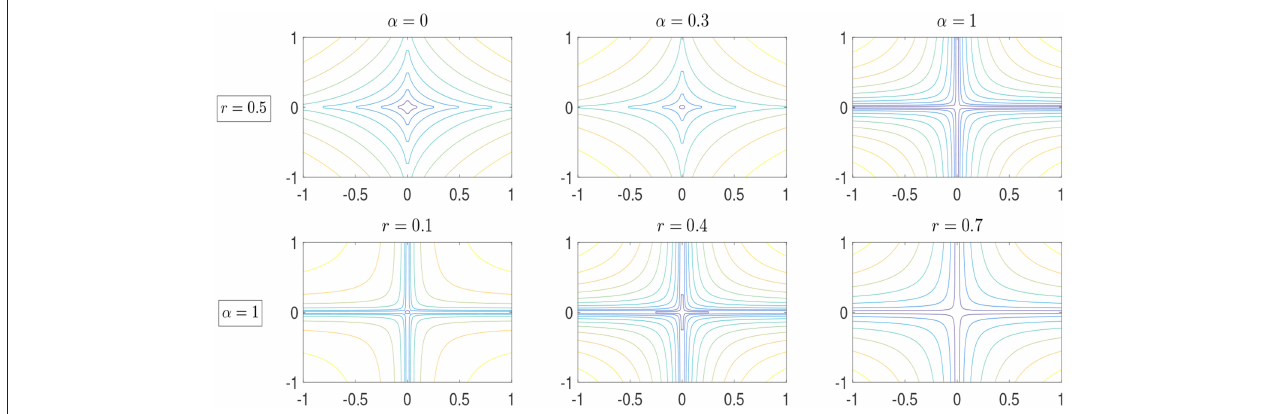
0.5 with different α 0,0.3,1, while = =